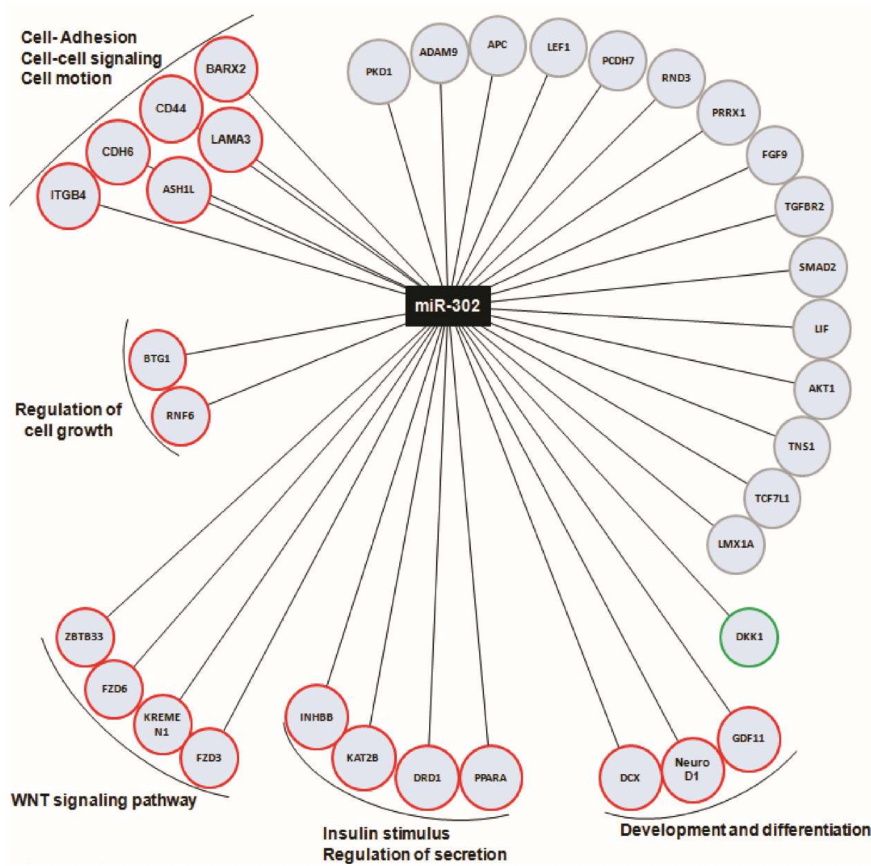
Figure 5. miR-302s target genes are involved in the loss of epithelial phenotype. miR-302 family are downregulated in islet-derived dedifferentiated cells respect to native human islets and are mainly involved in cell adhesion and motion, cell–cell signaling, cell growth, development and differentiation, WNT signaling pathway and insulin stimulus, as well as regulation of secretion. The scheme reports the entire set of analyzed miR-302s target genes; downregulated genes in islet-derived dedifferentiated cells are reported in red, while those upregulated are in green. Grey highlighted miR-302s target gene did not show any significant differential expression upon